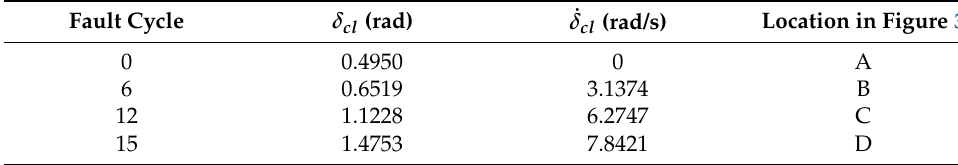
Table 1. Rotor angle and speed after fault is